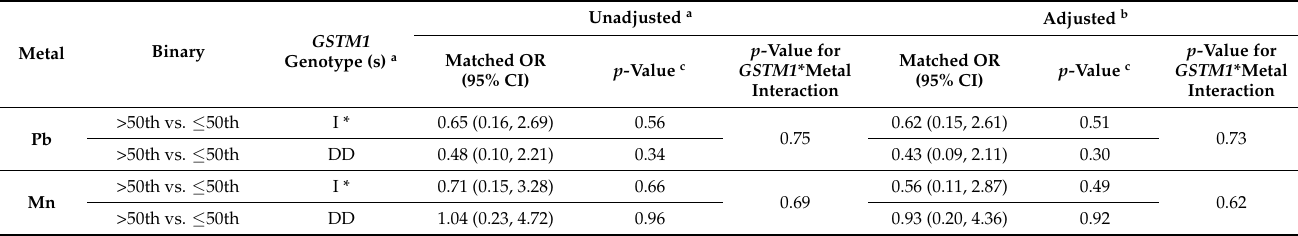
Table 6. Interaction of GSTM1 genotypes with blood Lead (Pb), Manganese (Mn) concentration (under a dominant genetic model) in relation to ASD in Pakistani children based on the CLR model. (N = 30 matched